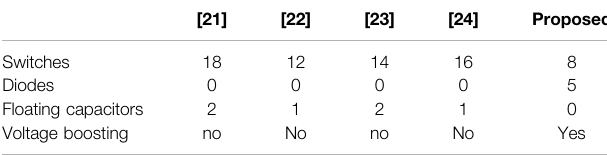
TABLE 2 | Comparison between different 7-level multilevel converters. TABLE 3 | Circuit parameters.